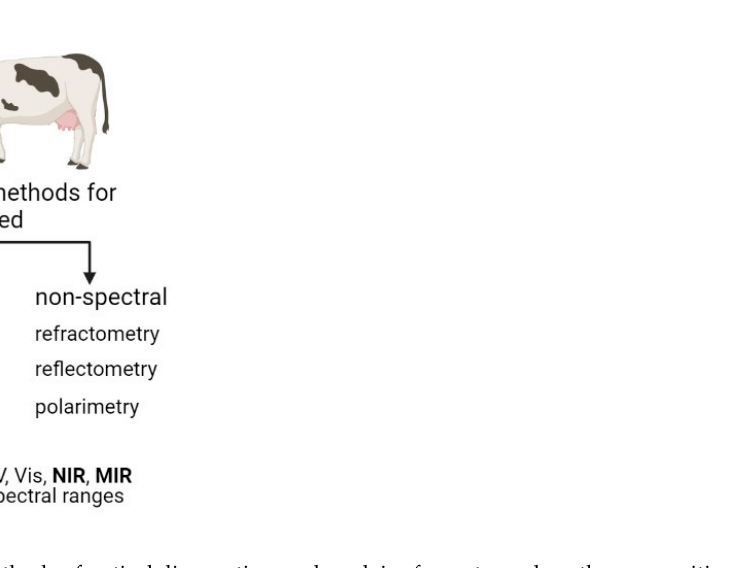
Figure 1. The main methods of optical diagnostics used on dairy farms to analyze the composition of milk and feed.